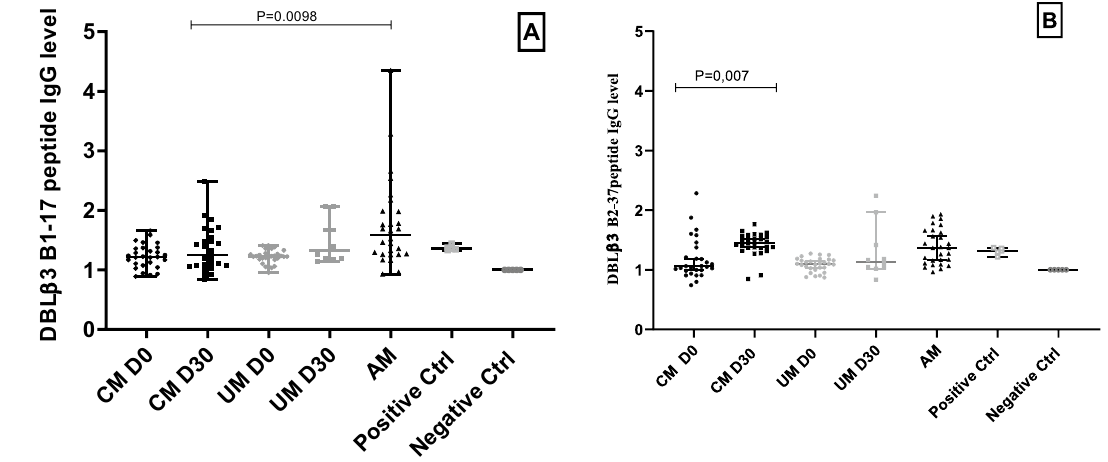
Figure 2. ( A , IgG response against DBLβ3 B1-17 in children with CM at Day 0 black circles, at Day 30 black squares and children with UM at Day 0 Grey circles and at Day 30 Grey squares. ( B ) IgG response against DBLβ3 B2-37 peptides in children with CM at Day 0 black circles and at Day 30 black squares and in children with UM gray circles at Day 0 and gray squares at Day